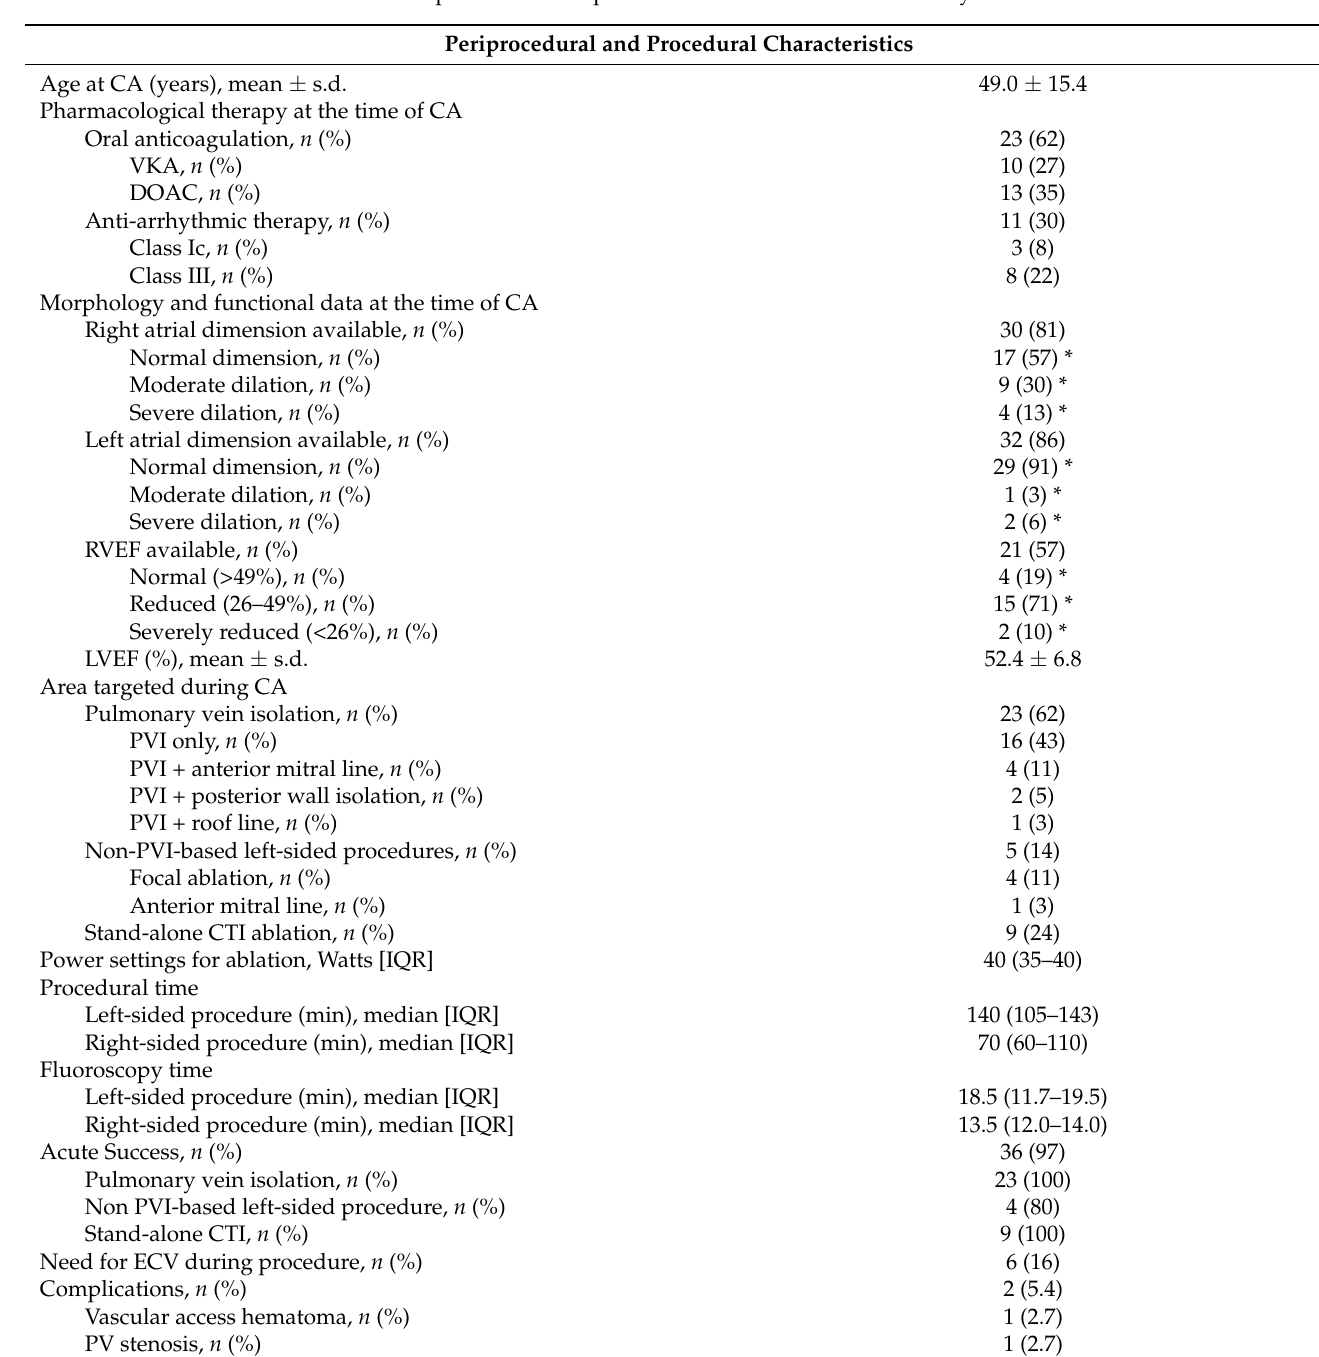
Table 3. Periprocedural and procedural characteristics of the study